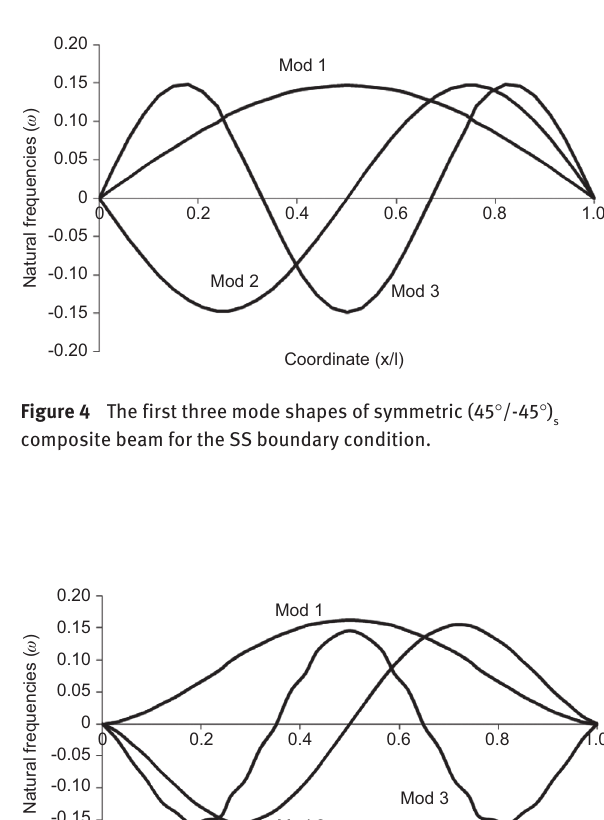
Figure 5 The first three mode shapes of symmetric (45 ° /-45 ° ) composite beam for the CC boundary condition.